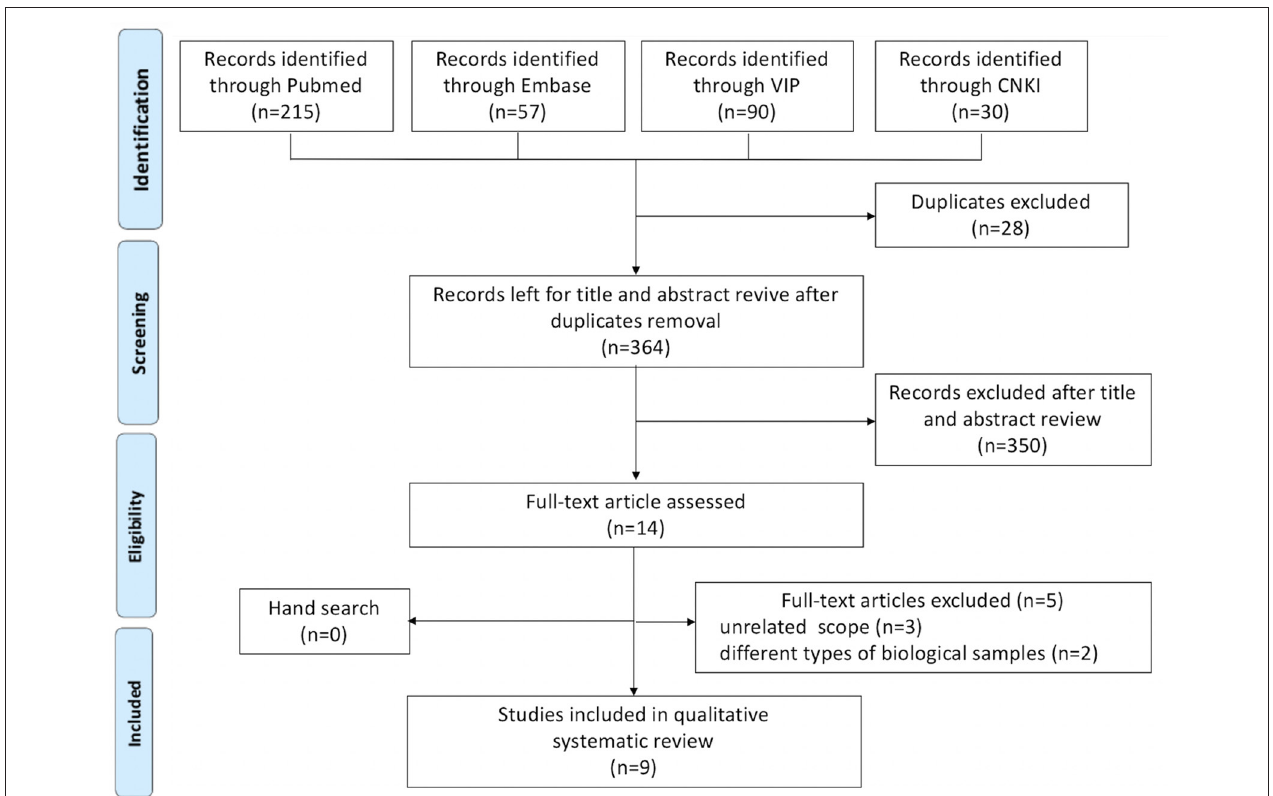
FIGURE 1 | Flow diagram of literature search and study